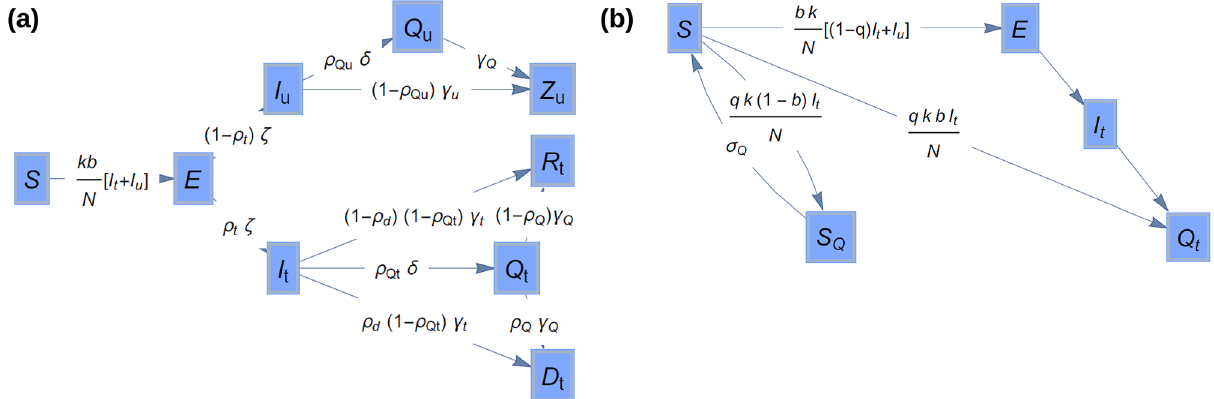
Figure 2. Model 2. ( a ) Extension of the flow diagram of model 1 (see Fig. 1) to incorporate a compartment Q t for isolation of tested infectious individuals and a compartment Q u for isolation of untested infectious individuals. ( b ) Flow diagram showing the implementation of contact tracing in model